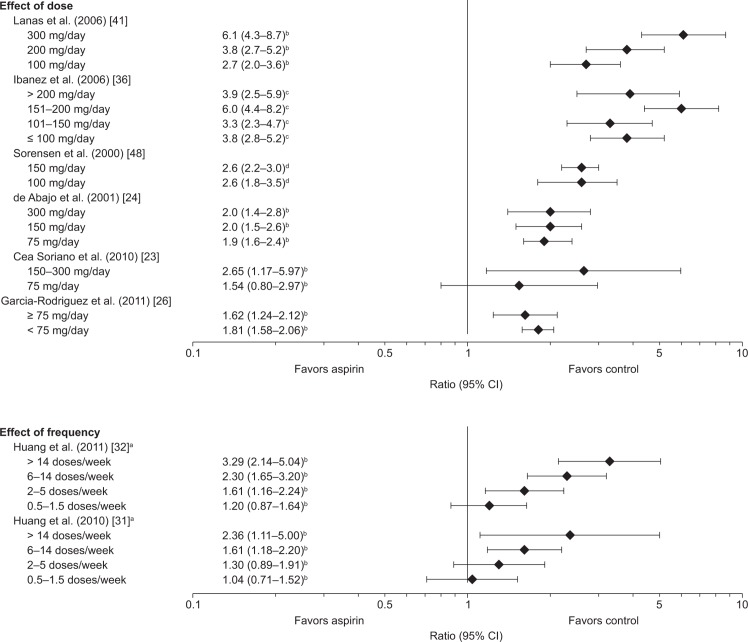
Risk of upper gastrointestinal bleeding with low-dose aspirin: effects of dose and frequency of use.Data are shown as adjusted RR, adjusted OR, or SIR, plus 95% CIs, for the risk of upper gastrointestinal bleeding with low-dose aspirin vs no aspirin. aOne dose equals one 325 mg tablet; badjusted RR; cAdjusted OR; dSIR. CI, confidence interval; OR, odds ratio; RR, relative risk; SIR standardized incidence ratio.